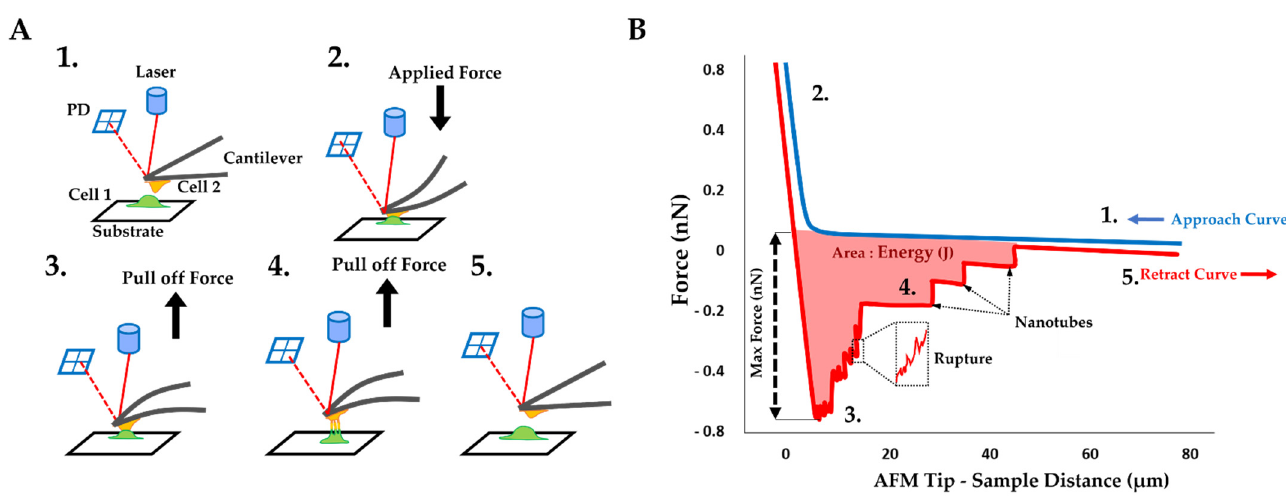
Figure 4. Cell-cell adhesion experiments by AFM. ( A ) Cell-cell adhesion setup: 1: Initial position with a fibroblast (cell 1) immobilized by fibronectin on support and a second cell (cell 2, yellow) attached to a tipless AFM cantilever coated with fibronectin driven by a wide-range (100 µm) piezo element. 2: Contact between cells by vertical force applied on the cantilever. The force on the cantilever is monitored by the deflection of a laser beam focused on the cantilever end and recorded by the photodiode (PD). 3: Cantilever retract step, producing a cells separation by a short distance. 4: Cantilever retract step, separation of cells over a longer distance and TNT formation. 5: Return to the initial step and total separation between cell 1 and cell 2. ( B ) Force–curve principle. Characteristic force curve recorded by PD, representing the force on the cantilever and the displacement during a cell–cell detachment and separation experiment: during the approach step (blue), the cell on the cantilever is brought into contact at a constant velocity, then the cell is retracted (red curve), until it goes back to the initial position going through a different pattern.